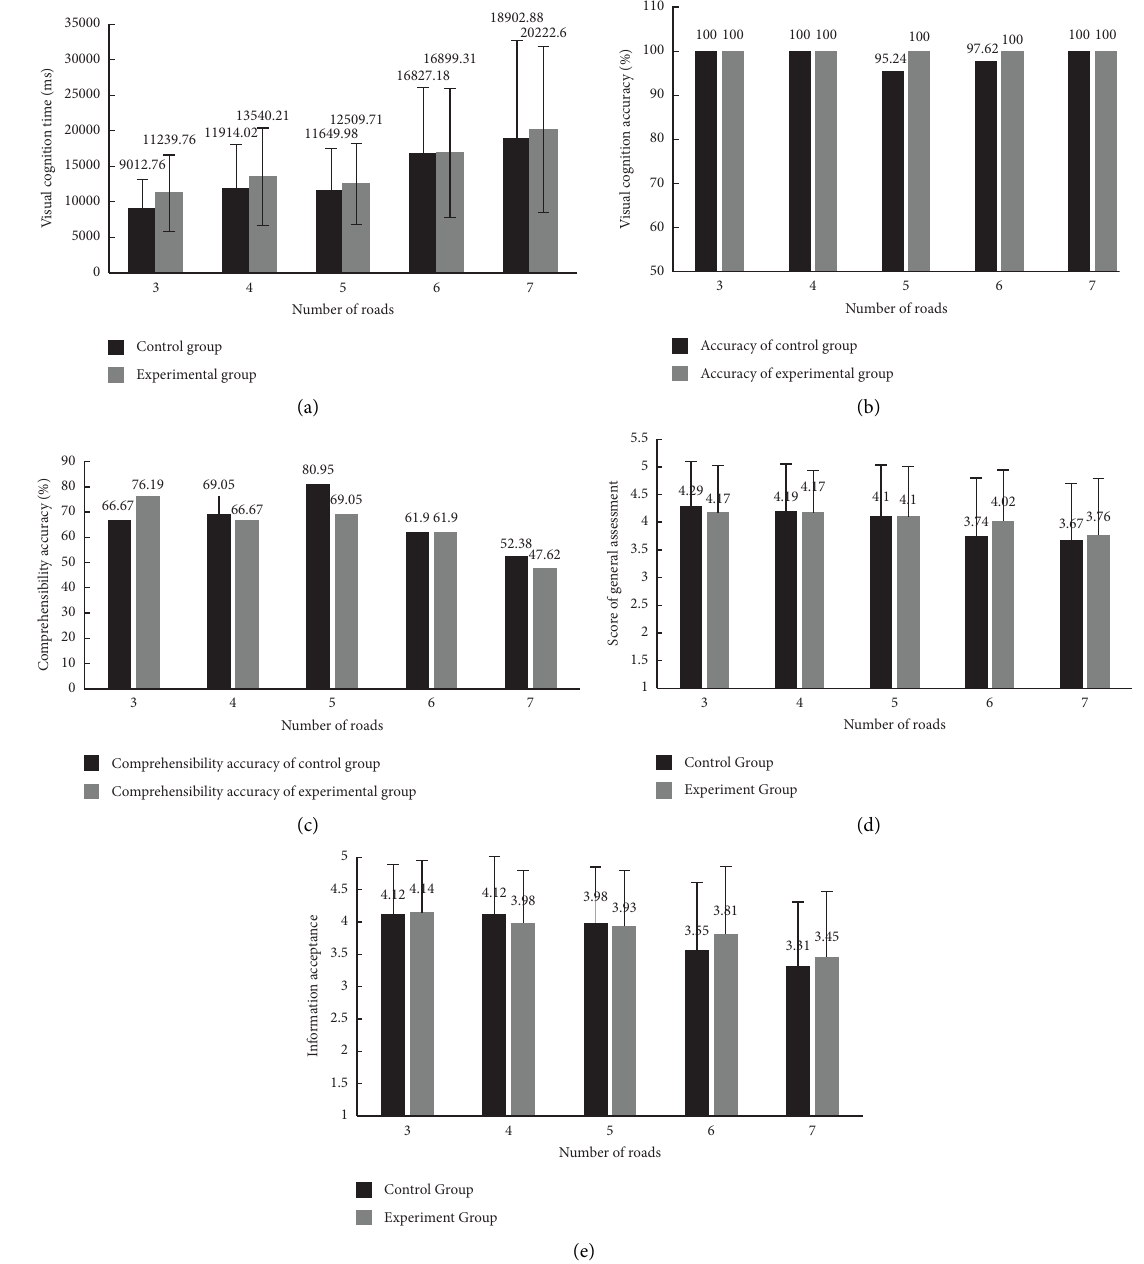
Figure 7: Te trend of change for diferent indexes. (a) Visual cognition time. (b) Visual cognition accuracy. (c) Comprehensibility accuracy. (d) Score of general assessment. (e) Information